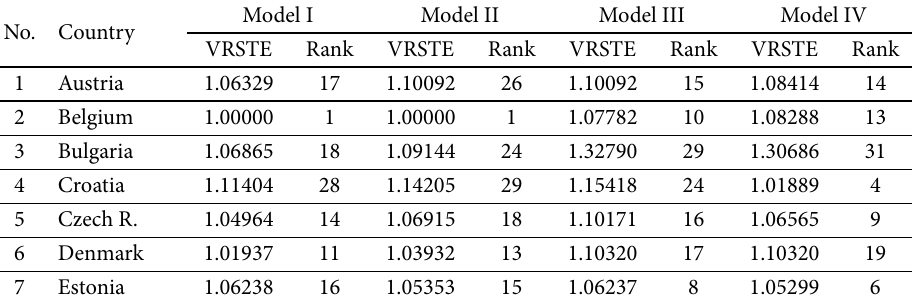
Table 3. DEA results for public secondary education efficiency in selected OECD and EU (plus Croatia) countries No.